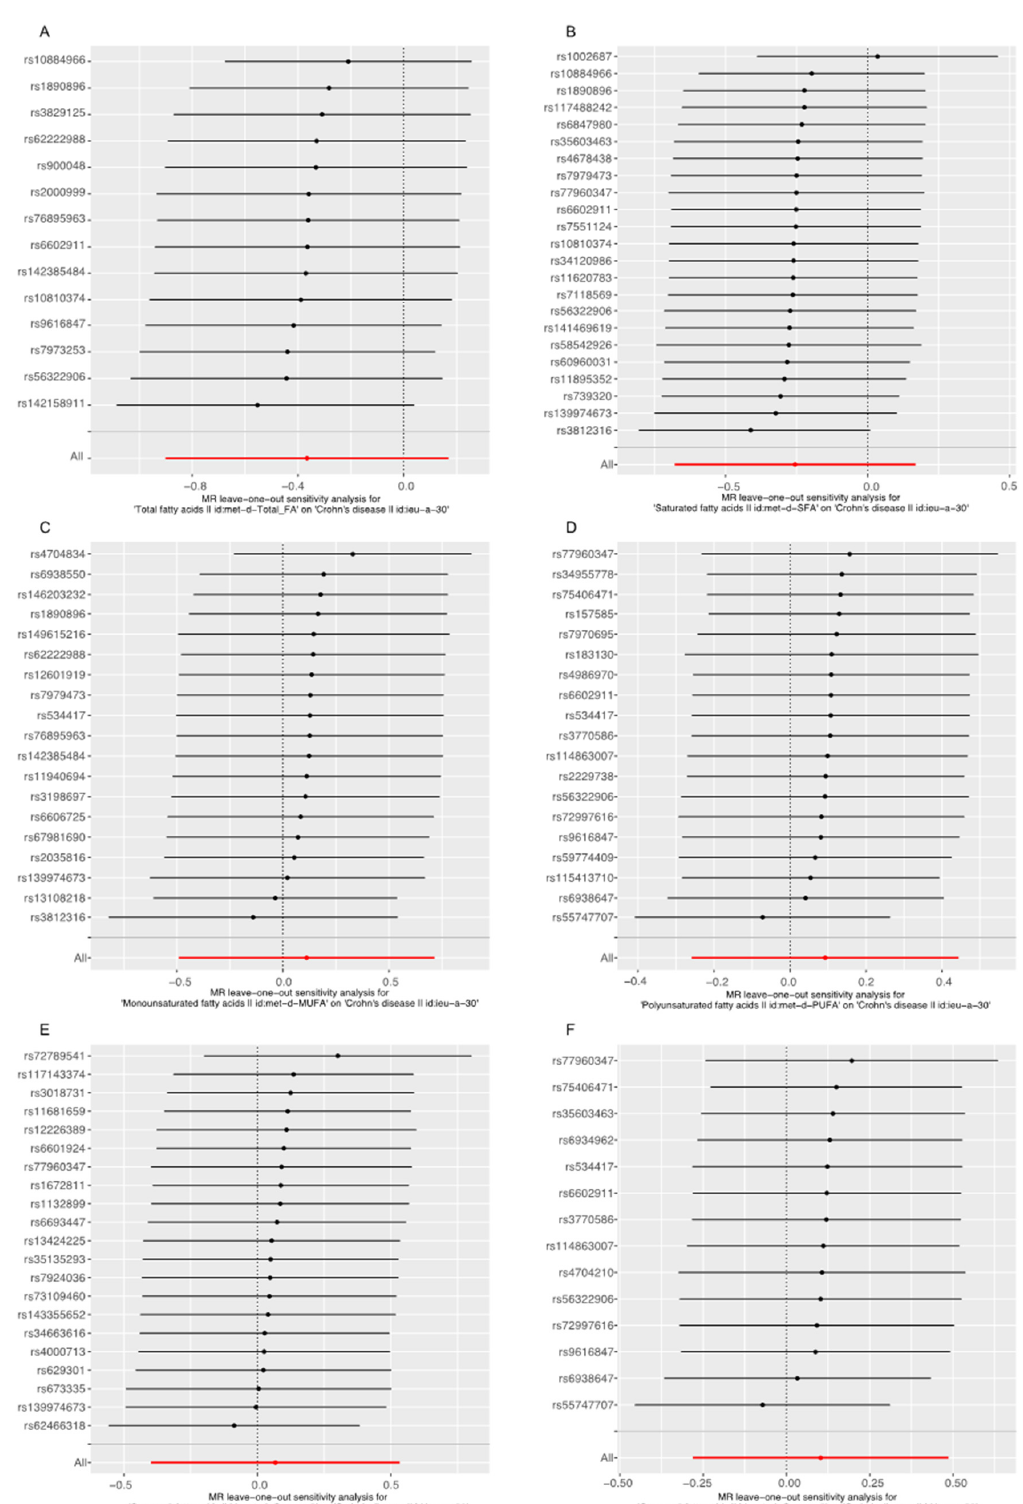
Figure 4. Leave-one-out analysis for the effect of fatty acids (FAs) and Crohn’s disease (CD). ( A ) Analysis of Total FA and CD; ( B ) Analysis of saturated FA and CD; ( C ) Analysis of monounsatu- rated FA and CD; ( D ) Analysis of polyunsaturated FA and CD; ( E ) Analysis of Omega-3 FA and CD; ( F ) Analysis of Omega-6 FA and CD.